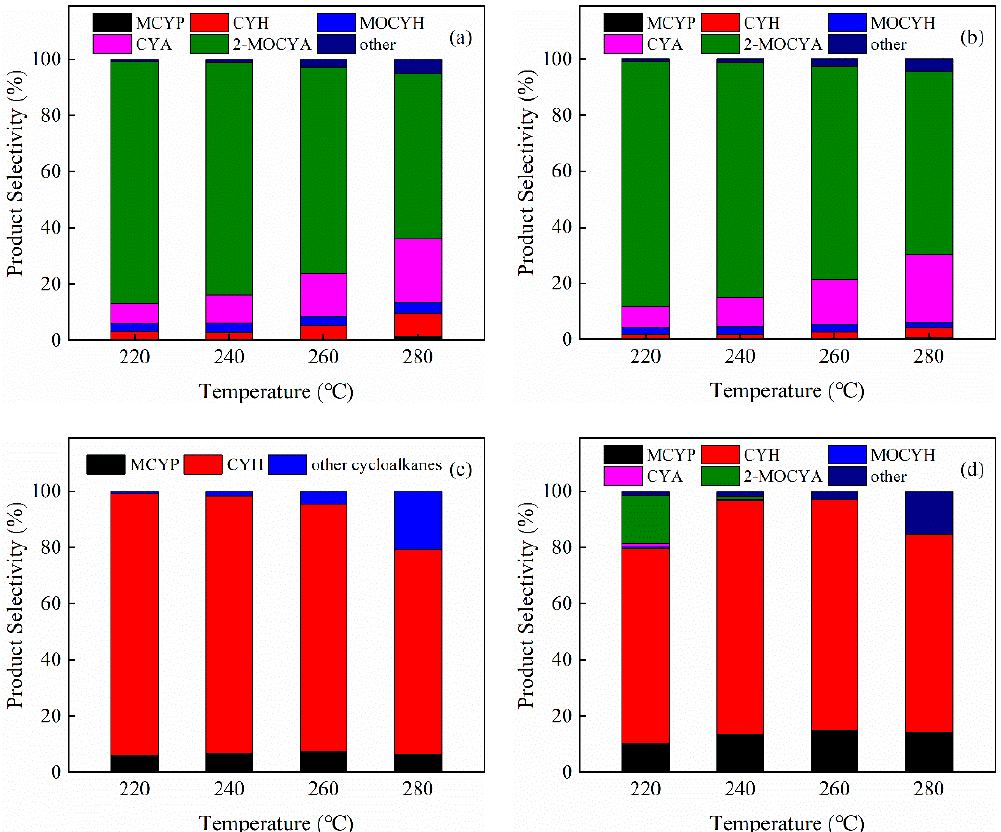
Figure 8. Product selectivity as a function of temperature over different catalysts: ( a ) Pt/S-1, ( b ) Pt/hS-1, ( c ) Pt/hZSM-5 and ( d ) Pt/cZSM-5 catalysts (MCYP: methylcyclopentane, CYH: cyclohexane, MOCYH: methoxycyclohexane, CYA: cyclohexanol, 2-MOCYA: 2-methoxycyclohexanol, and others: Mainly, cyclohexanone for ( a , b ) and cyclopentane for ( c , d )).